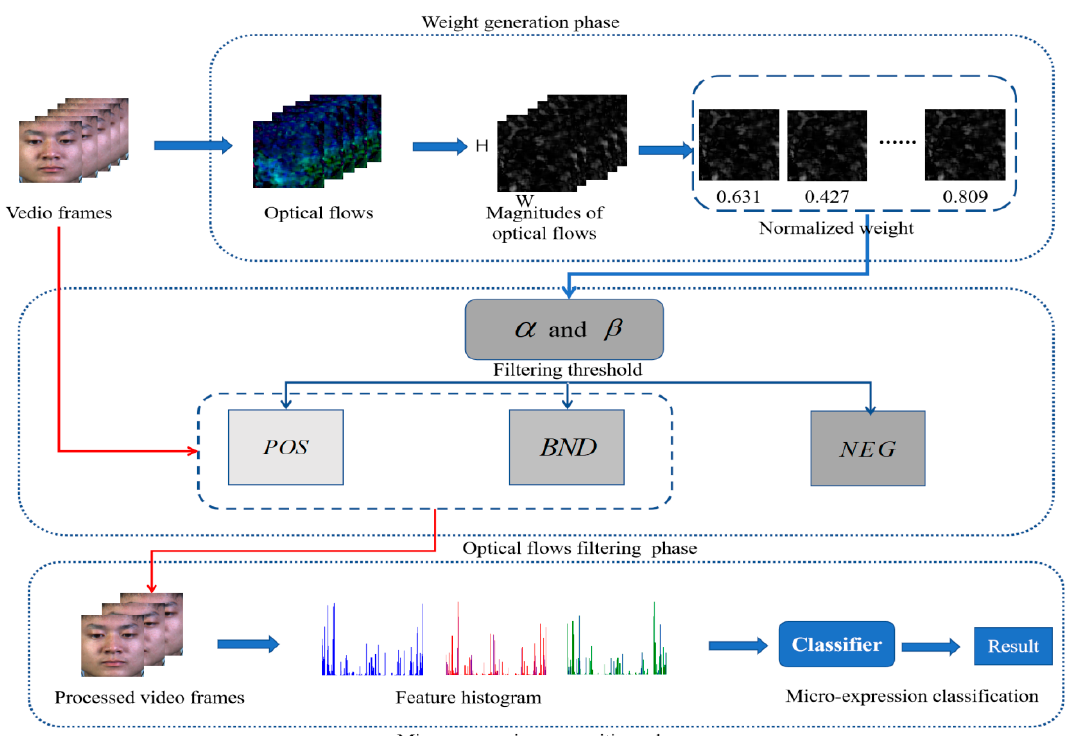
Figure 1. Framework of our proposed micro-expression recognition based on OFF3WD.